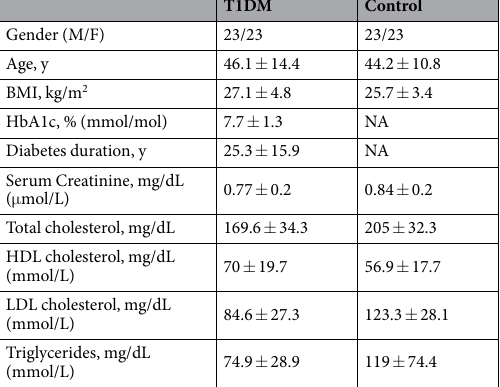
Table 1. Characteristics of the T1DM and control subjects included in the